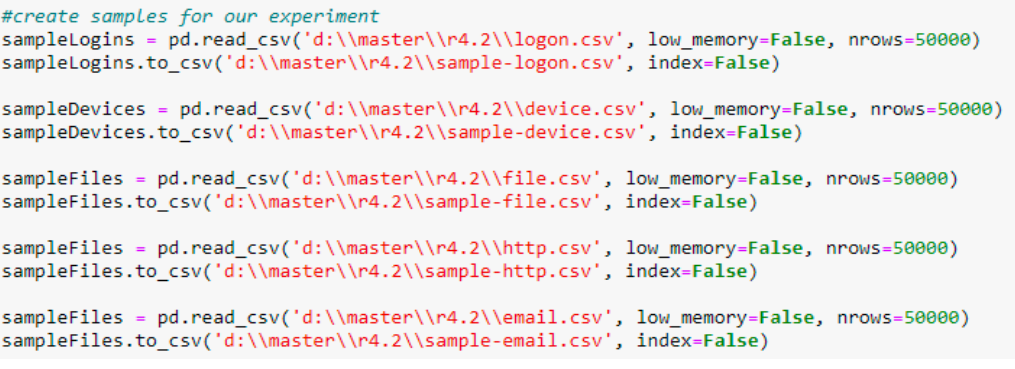
Table 4. Feature selection optimization results.